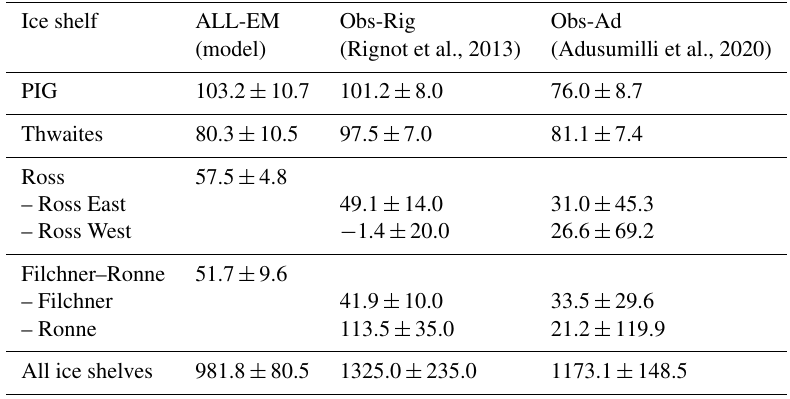
Figure 5. (a) IMBIE (Ice sheet Mass Balance Inter-comparison Exercise) 1992–2017 mean observed elevation change rate (myr − 1 ). Ice shelves and some grounded regions in the Antarctic Peninsula are not covered by the data. (b) 2020–2030 mean modelled elevation change rate (myr − 1 ). (c) 2020–2030 difference in mean elevation change rate (myr − 1 ) between the SSP5–8.5 and SSP1–1.9 scenario. (d) 2020– 2030 mean surface velocity anomaly (myr − 1 ) with respect to the reference ice state (Cornford et al., 2016). The black and grey lines in (b) , (c) and (d) are the ice sheet grounding lines and ice shelf fronts, respectively. Table 1. Ice shelf basal melt flux (in Gtyr − 1 ) under some selected Antarctic ice shelves from the model and observations. The result from the model is represented by the whole ensemble mean (ALL-EM) which encompasses both scenario members averaged between the year 2020 and 2030. In both observations, the Ross basal melt flux is split into the Ross East and Ross West regions, whereas the Filchner–Ronne melt flux is split into the Filchner and Ronne ice shelves. PIG: Pine Island